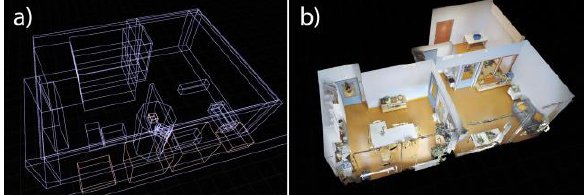
Figure 4. (a) The simplistic objects used as a collision model for physics modeling, (b) The rendered